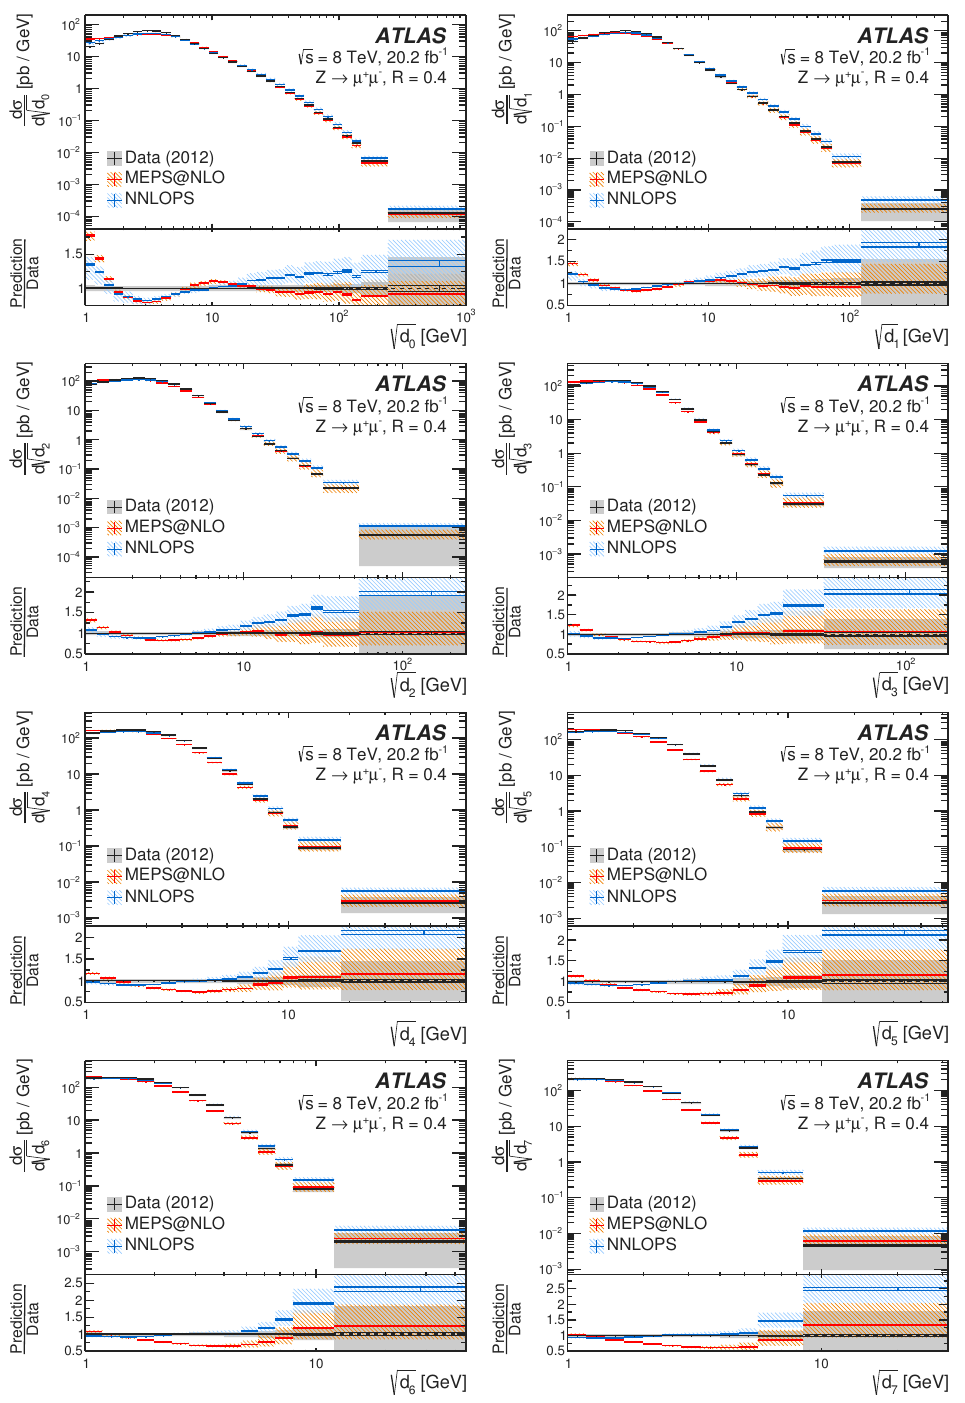
Figure 7. Charged-only distributions for the eight leading splitting scales in the muon chan- nel using the jet-radius parameter R = 0 : 4. The size of the error bars re(cid:13)ects the statistical uncertainty, while the combined statistical and systematic uncertainty is indicated by the grey band. Theoretical predictions from Sherpa with NLO multijet merging (\MEPS@NLO") and from Powheg + Pythia 8 with NNLO matching (\NNLOPS") are displayed.